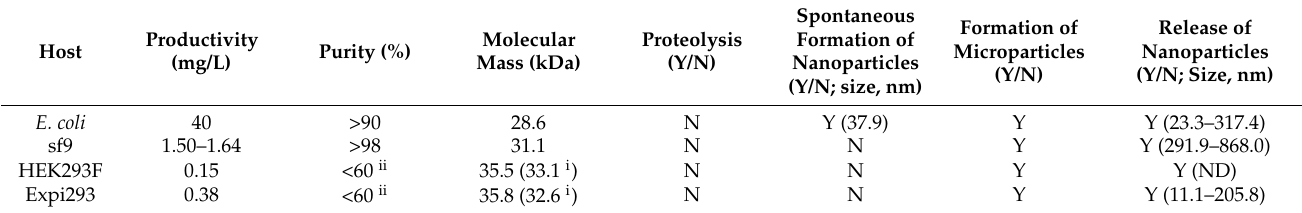
Table 1. Protein yield and purity of the tested protein production platforms.